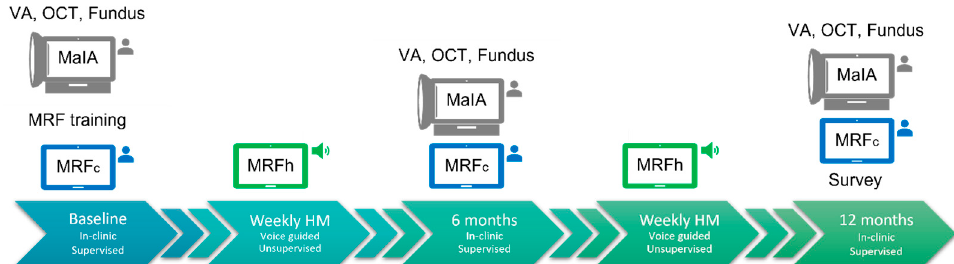
Figure 2. Timeline for the 12-month voice-guided telemedicine study outlined in the text. VA: Early Treatment Diabetic Retinopathy Study acuity chart viewed under normal clinical conditions (HVA) and through an ND2 filter (LLVA). OCT: Optical coherence tomography. Fundus: Dilated fundus exam. MAIA: Macular Integrity Assessment. MRFc: Melbourne Rapid Fields visual acuity and visual field testing performed in-clinic under supervision (cartoon of person at these times). MRFh: Melbourne Rapid fields visual acuity and visual fields performed at-home with app-generated au-